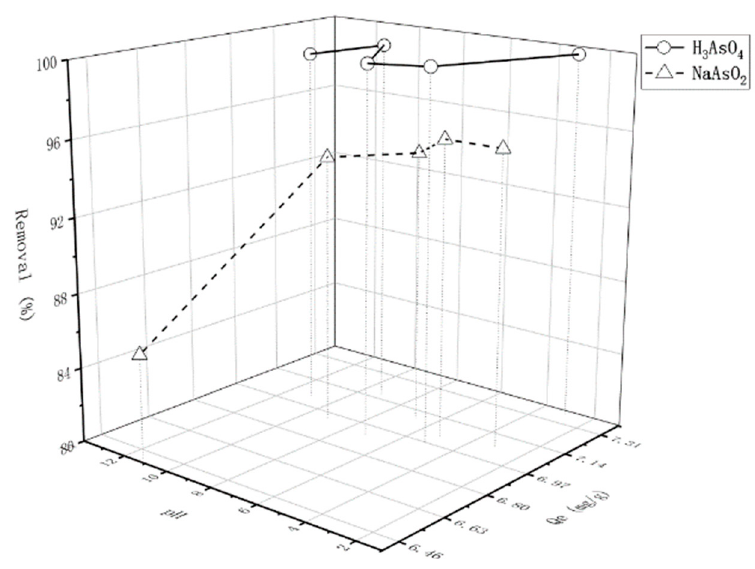
Figure 5. Effect of pH on arsenic removal by iowaite (- ○ -:H 3 AsO 4 ; - △ -: NaAsO 2 ).